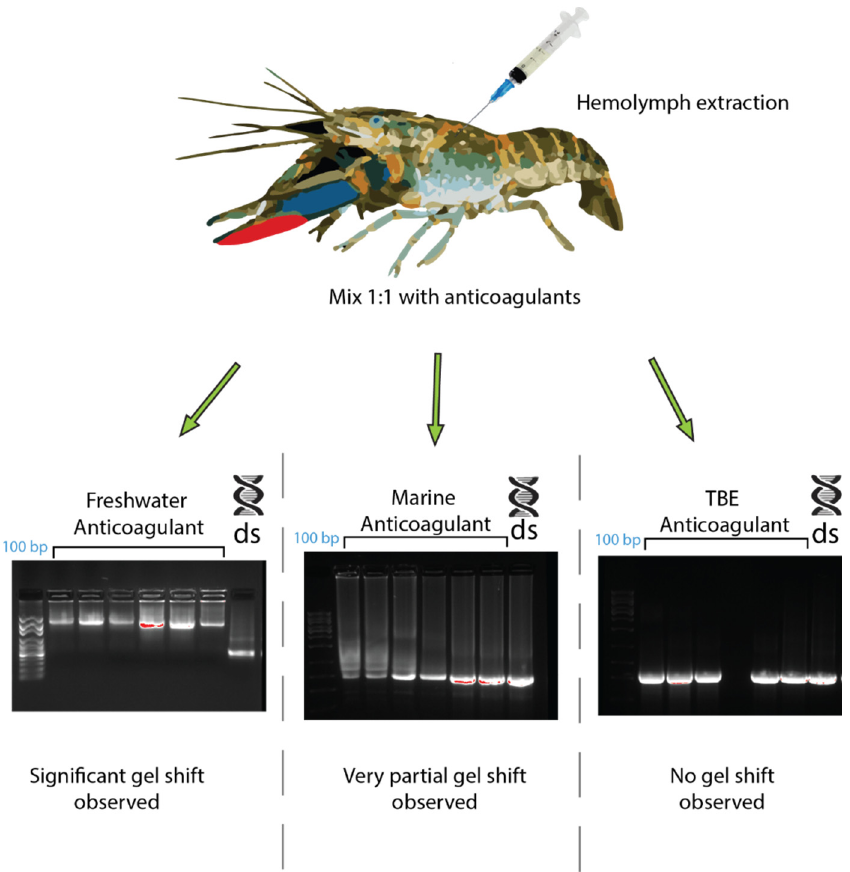
Figure 6. The effects of different anticoagulants on dsRNA–protein complex formation in Cherax quadricarinatus . The hemolymph from C. quadricarinatus was extracted and mixed with 1:1 volume of either freshwater, marine buffer, or TBE buffer anticoagulant on ice. The hemolymph was then centrifuged and serum was collected and incubated with 400 ng of dsRNA. After 10 min of incubation, samples were run on 1.2% agarose and the difference in binding capacity was observed. In each gel image, the first lane represents a 100 bp ladder, the next seven lanes represent dsRNA + serum with the respective anticoagulant, and the final lane is a dsRNA + water control.